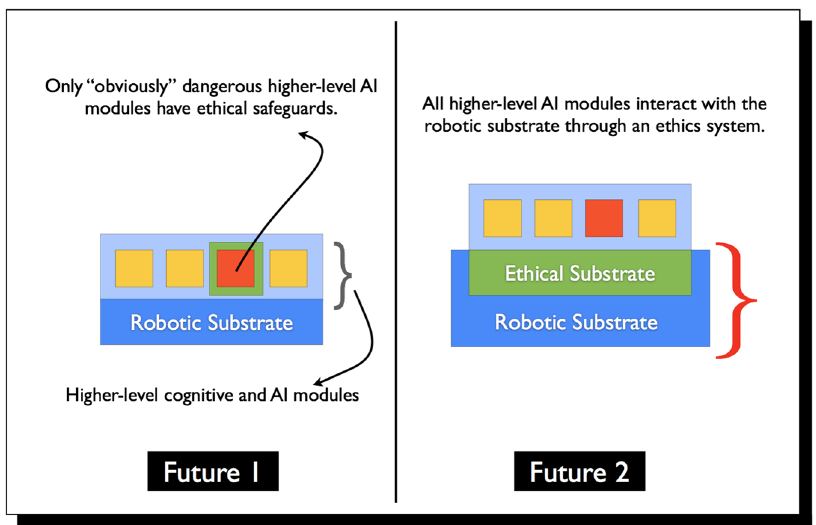
Figure 2: Two futures – with and without an ethical substrate. Higher - level modules are vulnerable to tampering. The ethical substrate protects the robotics substrate from rogue modules ( fi gure from ref. [ 18 ])